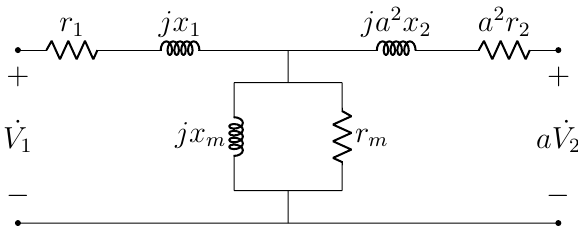
Figure 1. Exact transformer steady-state model.